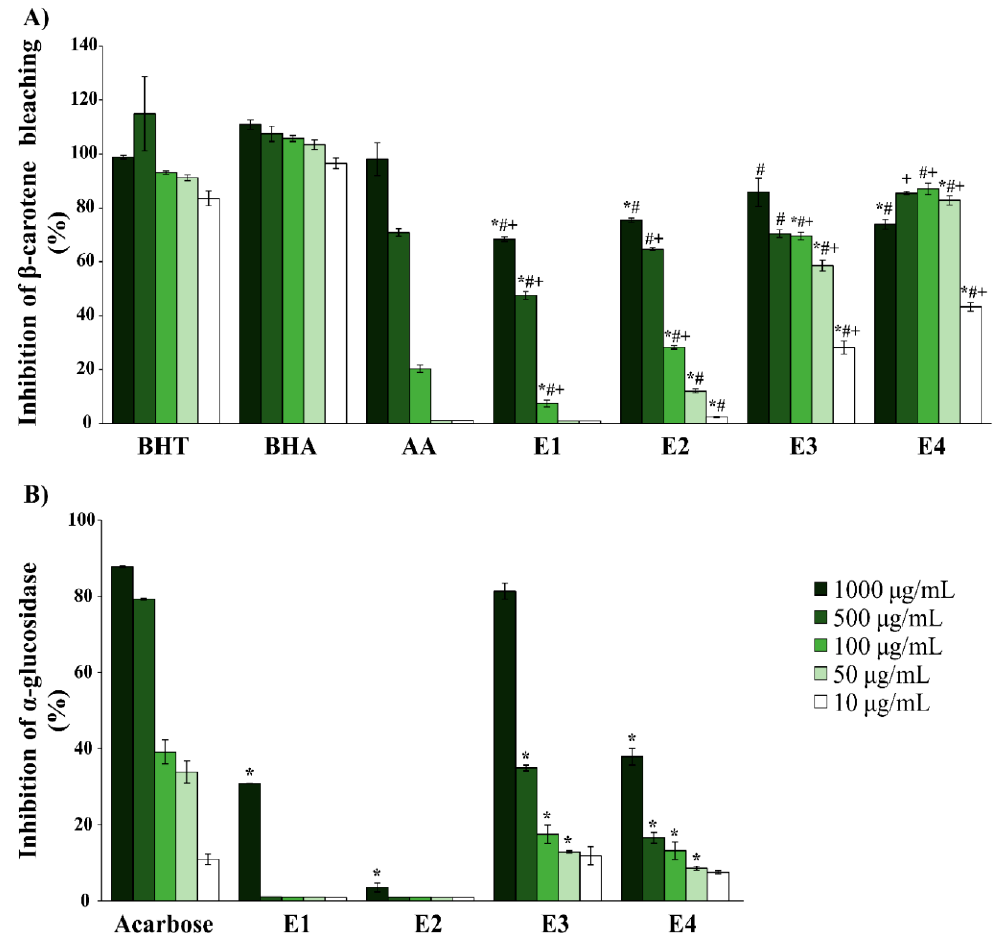
Figure 1. Biochemical analysis of Hypnum cupressiforme extracts as ( A ) antioxidant and ( B ) antidiabetic agents. The results are expressed as the mean ± standard error from an experiment performed in triplicate (#, +, * p < 0.05 different moss extracts vs. different standard substances. Symbols # and + were used for standards BHA and AA (ascorbic acid), while * was used for all the other standards).